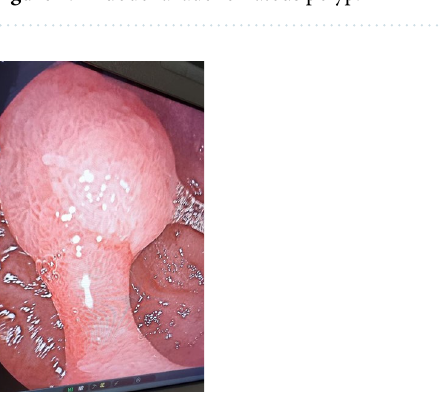
Figure 2. Duodenal adenomatous polyp.